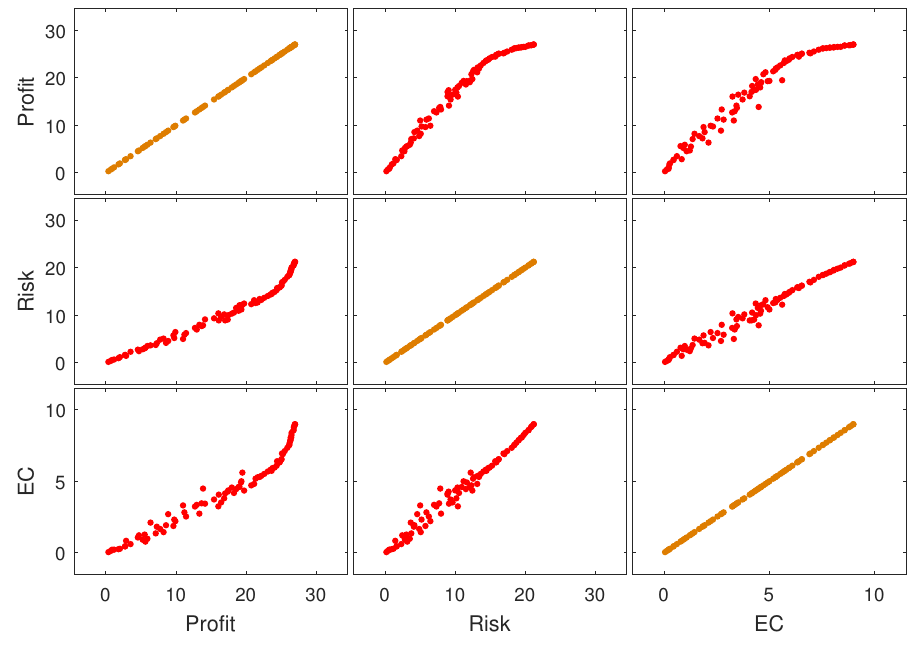
Figure 6. The description of the SPEA2